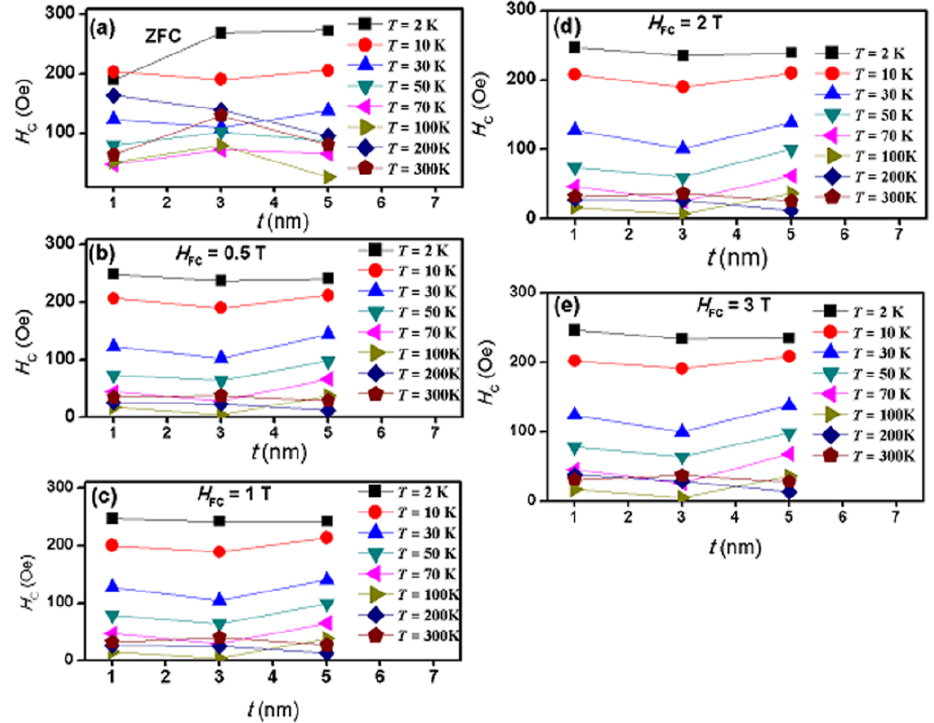
Figure 10. The coercivity as function of shell thickness at several temperatures in the ZFC state and in the FC state at several field-cooling values.